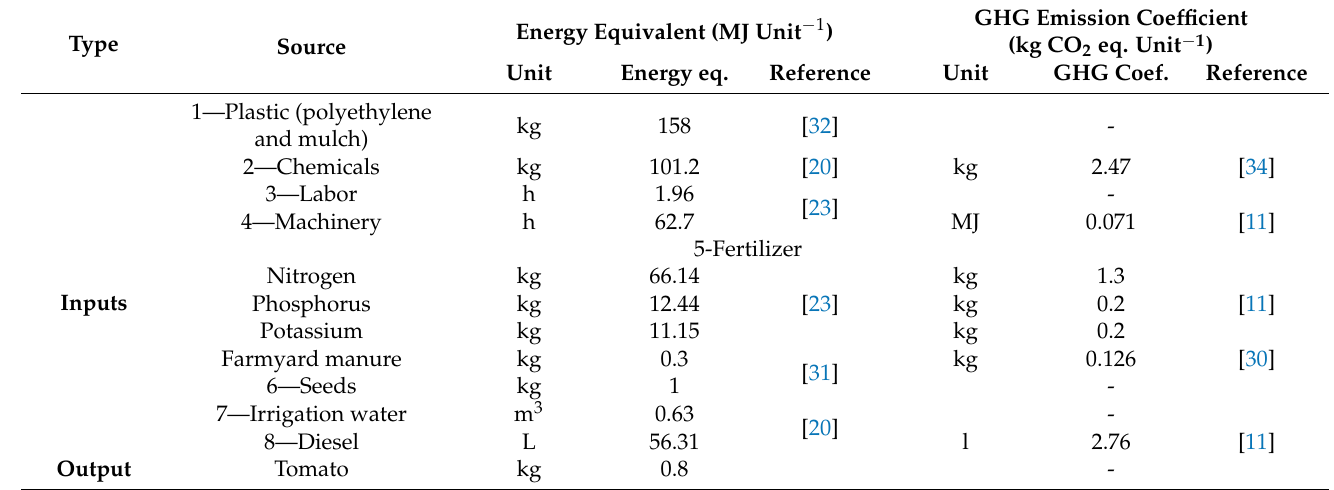
Table 1. Energy and GHG equivalents of agricultural input and output.